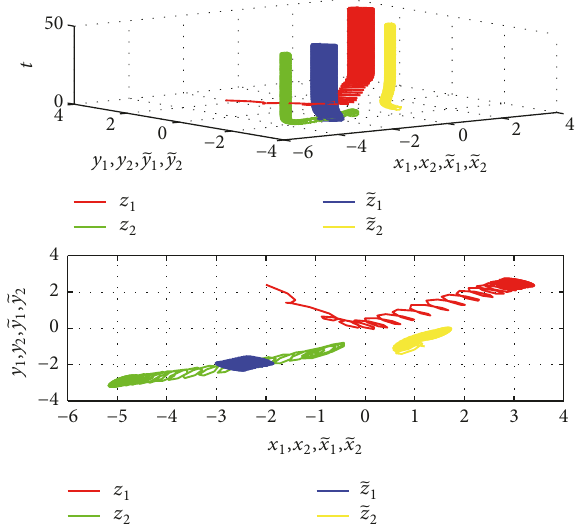
Figure 1: Time responses of the variables 𝑧 1 , 𝑧 2 , ̃𝑧 1 , and ̃𝑧 2 in 3D and 2D spaces without controller for example